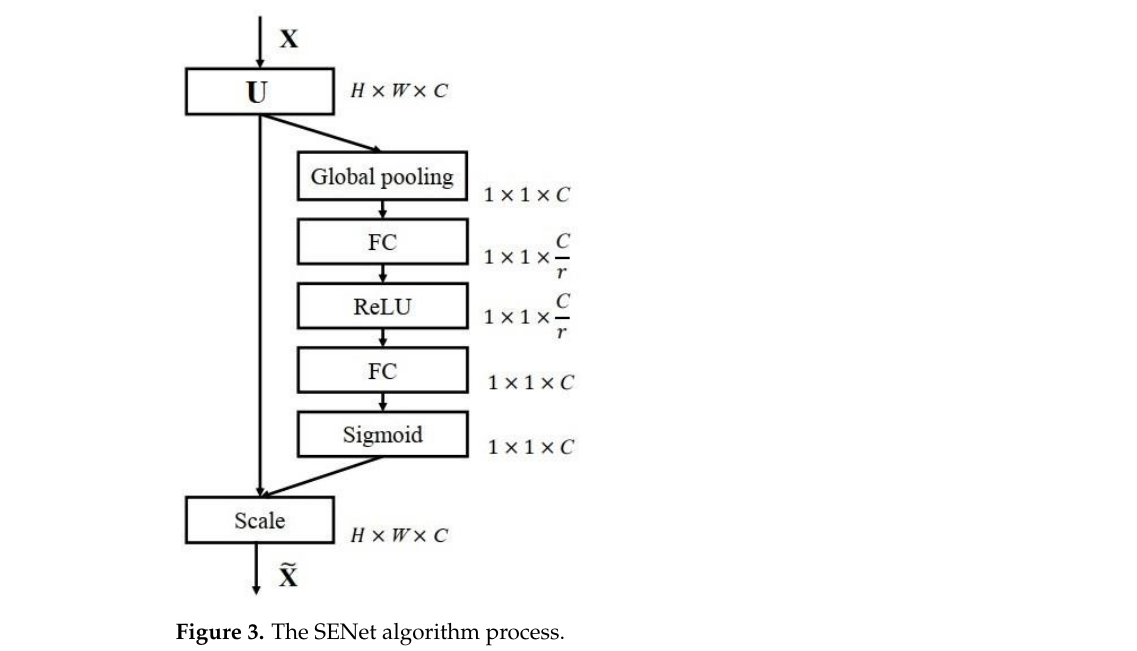
Figure 3. The SENet algorithm process.